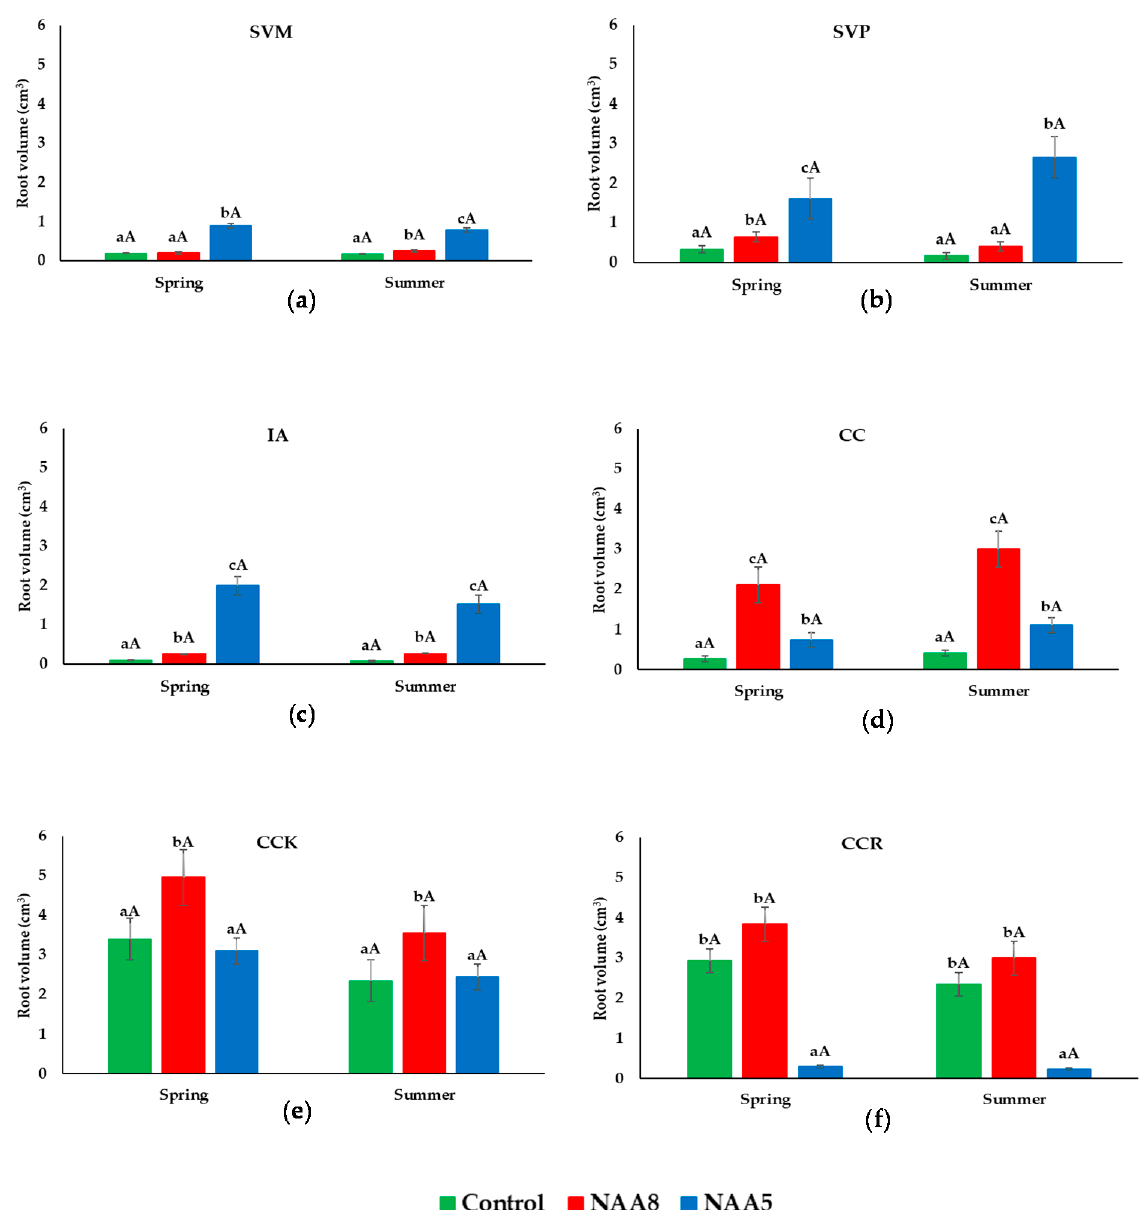
Figure 2. Effect of rooting stimulants (NAA8 and NAA5) on root volume in the six selected ornamental shrubs: ( a ) Syringa vulgaris ‘Mme Lemoine’ (SVM); ( b ) Syringa vulgaris ‘President Grevy’ (SVP); ( c ) Ilex aquifolium (IA); ( d ) Cotinus coggygria (CC); ( e ) Cotinus coggygria ‘Kanari’ (CCK); ( f ) Cotinus coggygria ‘Royal Purple’ (CCR). Bars represent the means ± SE ( n = 30). Different lowercase letters above the bars indicate significant differences between the treatments, and different uppercase letters indicate the significant differences between the spring and summer propagated cuttings, according to Tukey’s test ( α = 0.05).